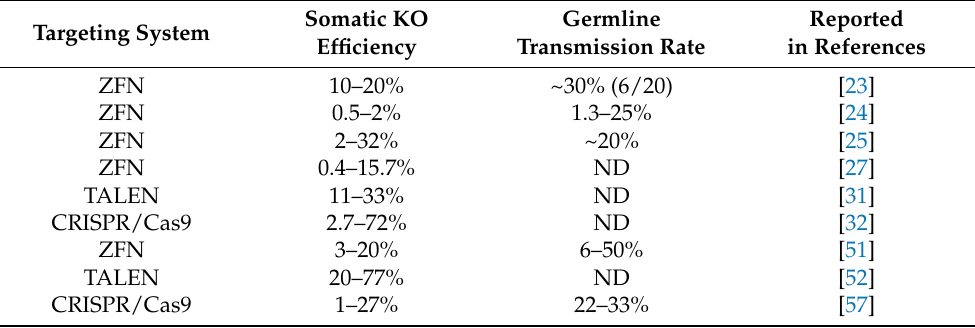
Table 1. Summary of gene knockout (KO) studies using ZFN, TALEN, and CRISPR/Cas9 in